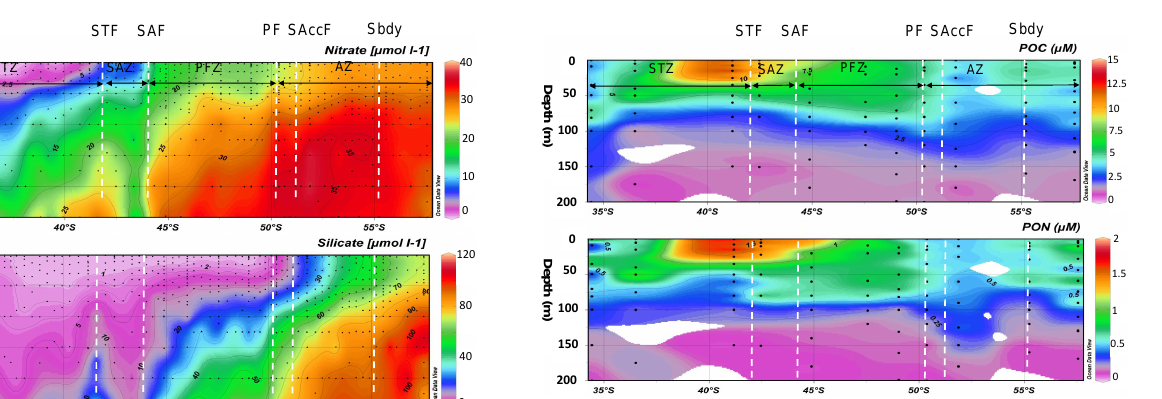
Figure 3 e, f. (cont.) Profiles of Particulate Organic Carbon (POC) and Particulate Organic Nitrogen (PON) in the upper 200 m of the water column along the Bonus Goodhope cruise track. Highest concentrations were observed equatorward of the Sub-Antarctic Front. Frontal positions are indicated by the white vertical dotted lines.